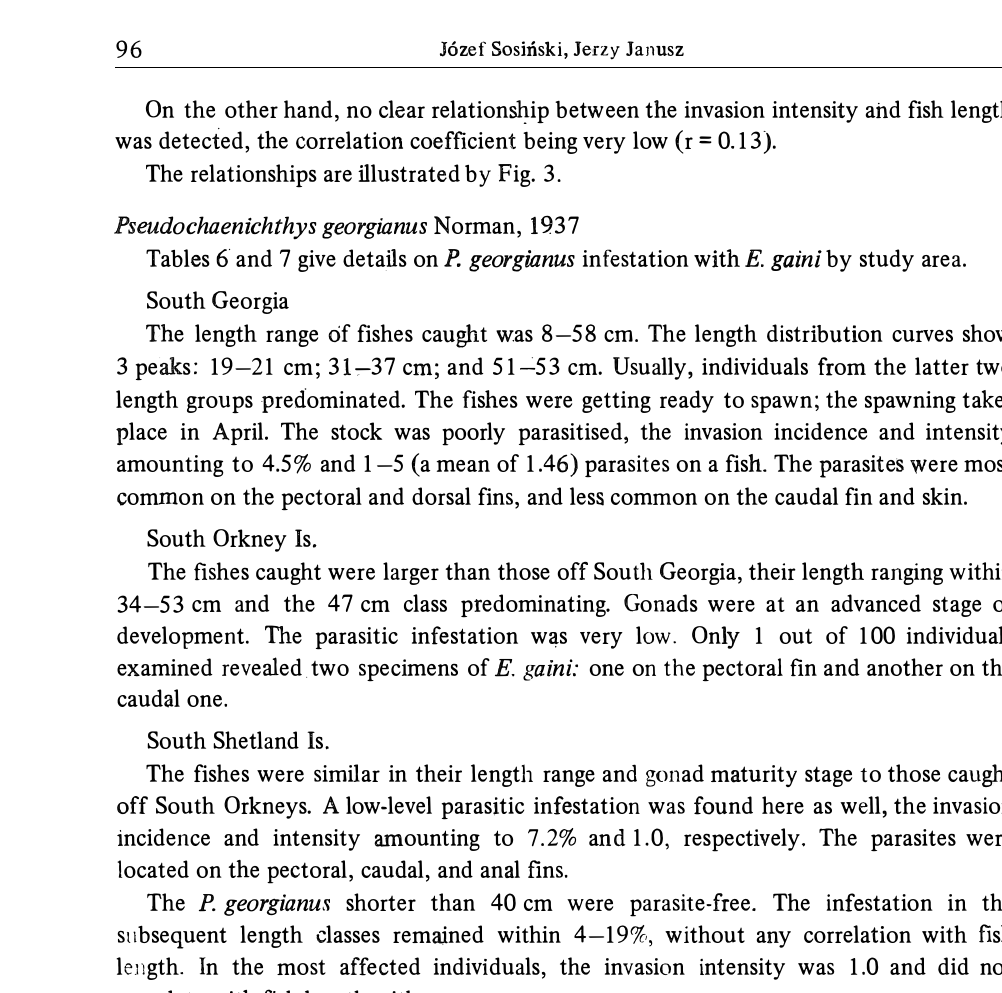
Chionodraco rastrospinosus* De Witt et Hureau, 1979 Data on details of the parasitic invasion .of the species can be found in Tables 8 and 9. South Orkney